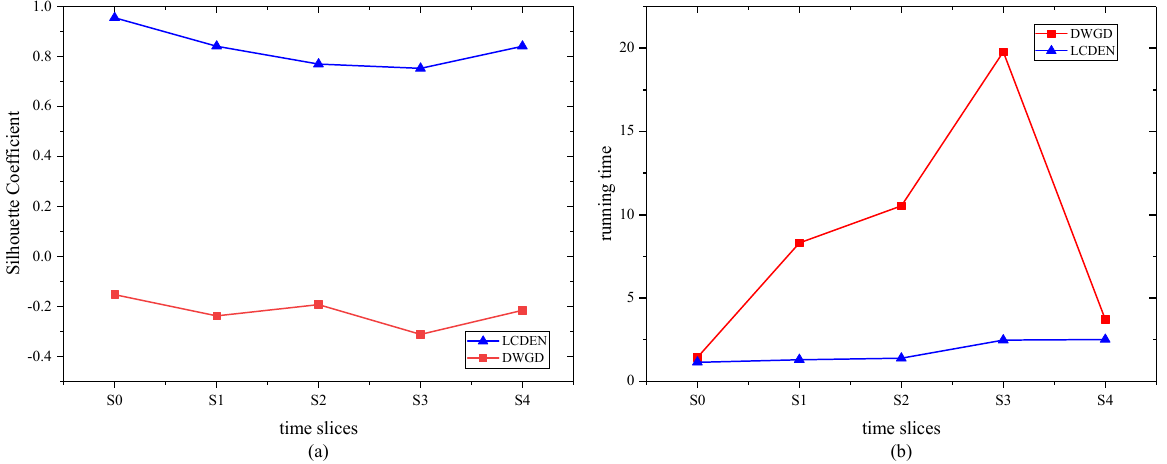
Figure 2. Comparison of the Silhouette Coefficient ( a ) and running time ( b ) on the Wiki-Talk-Temporal network.